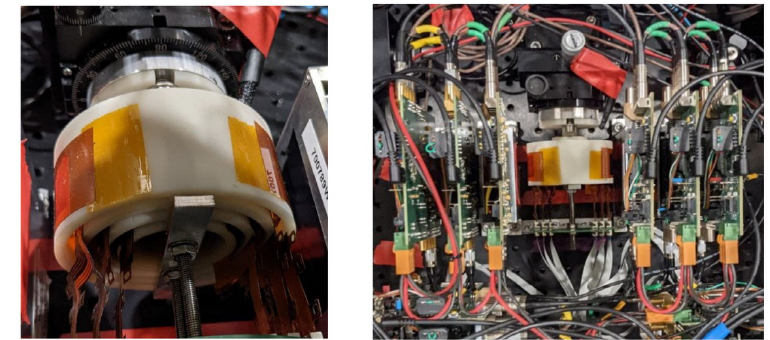
Fig. 5. (left) Image of the six DUTs used in the test-beam campaign, bent over three cylindrical jigs at different radii, forming the μ-ITS3. (right) Top view of the bent DUTs mounted within the ALPIDE beam